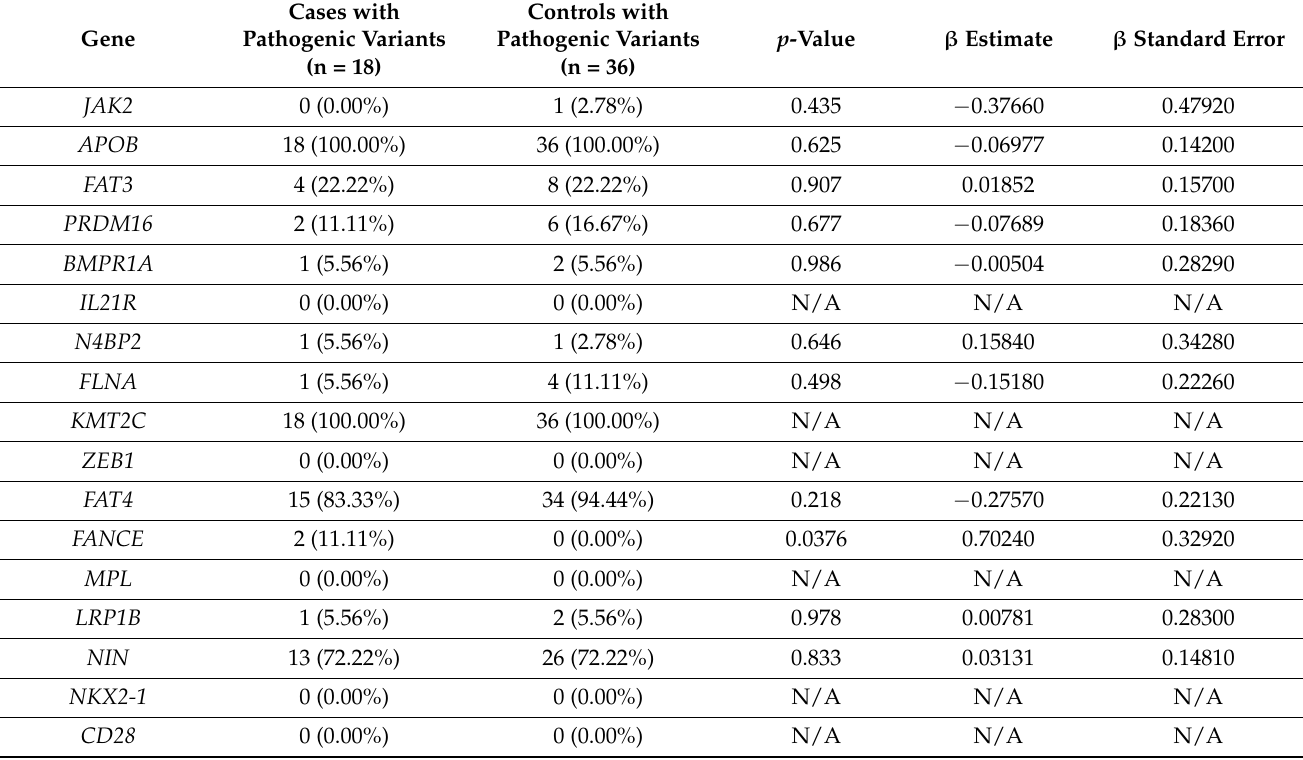
Table 4. Gene-based burden testing of 17 prioritised candidate genes in 16 probands and 38 family members (2 affected, 36